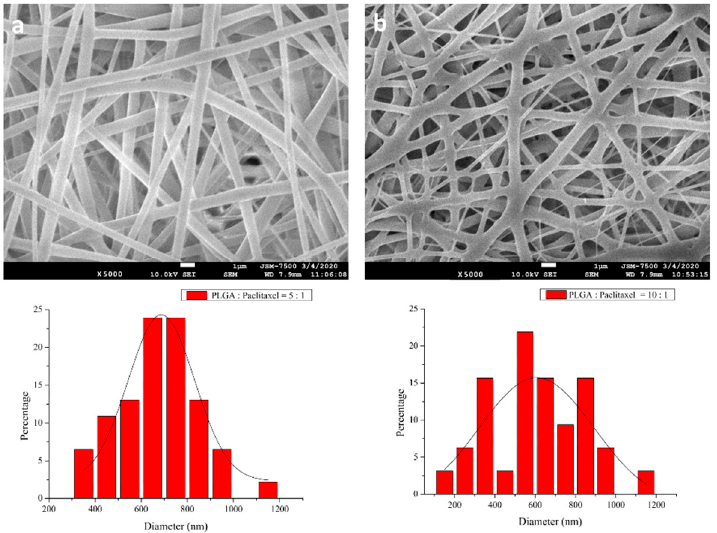
Figure 1. SEM images and diameter distributions of nanofibers with ( a ) 10:1 and ( b ) 5:1 polymer-to-drug ratios (magnification, 5000 × , scale bar: 1 μ m).